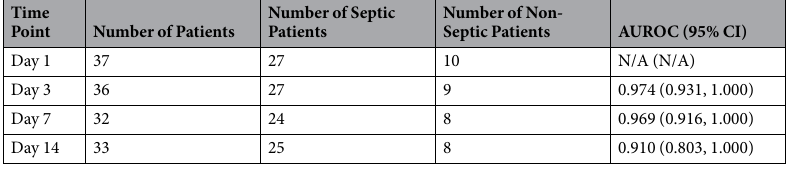
Table 4. Discriminatory power of a combination of NEUT-Y and platelet impedance count (PLT-I) for sepsis adjusted for mortality at different time points was assessed through area under the receiver operating characteristic curve (AUROC) analysis and shown with 95% confidence intervals. The model for Day 1 fails to converge due to a number of parameter combinations corresponding to zero observations in the